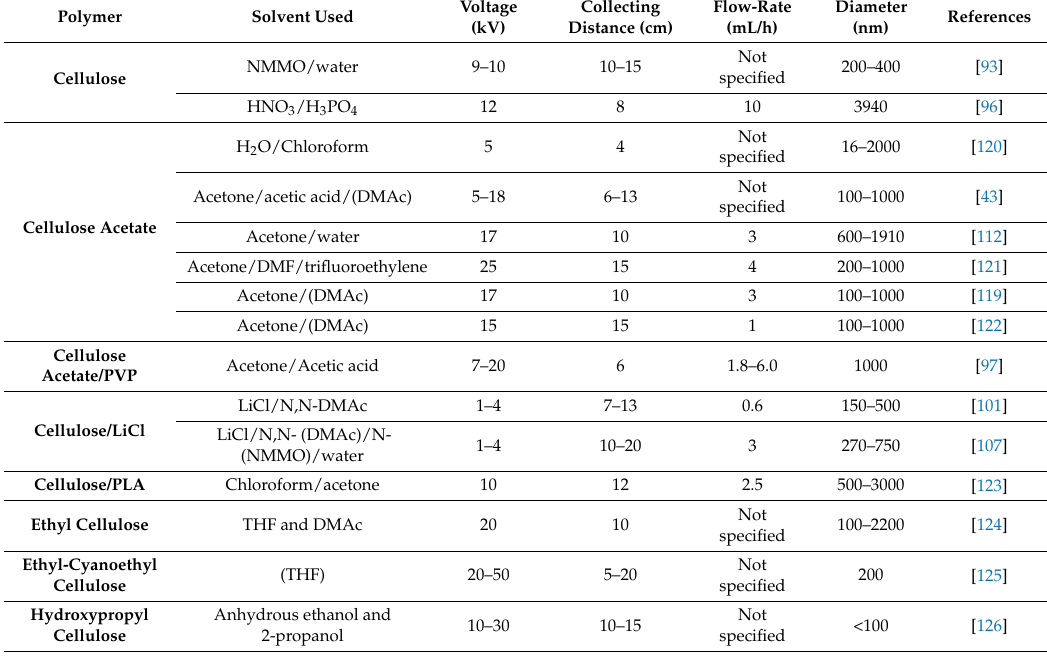
Table 1. Governing electrospinning parameters of cellulose and its derivatives, and their blends and nanofiber